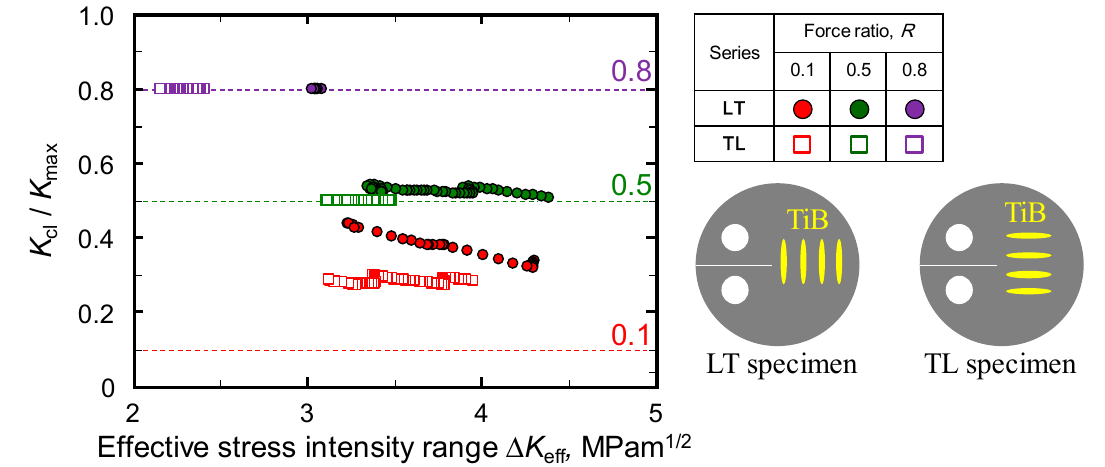
Figure 6. Relationship between K cl / K max and e ff ective stress intensity range for TiB / Ti-3Al-2.5V composites having di ff erent TiB